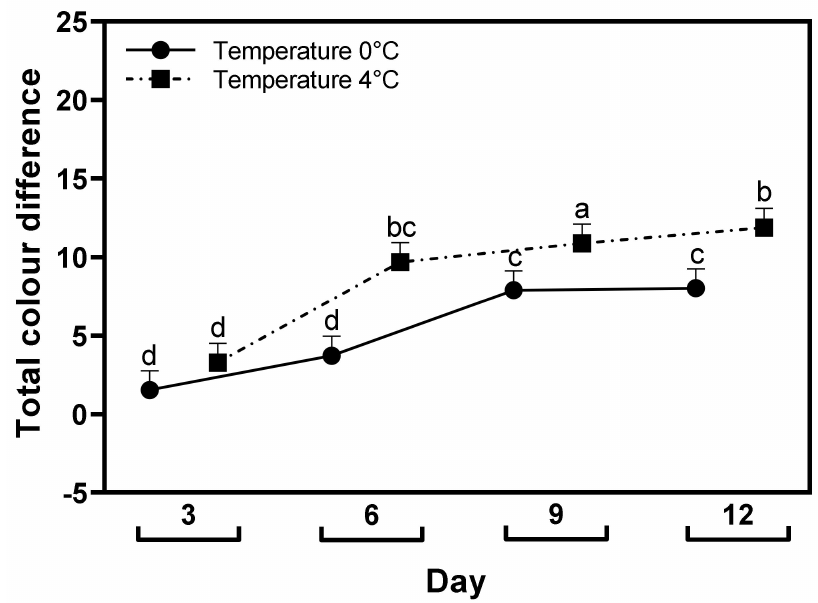
Figure 6. Effect of modified atmosphere packaging, temperature (0 ◦ C and 4 ◦ C), and duration (d) on total color difference of stored Cape hake fillets. Different letters indicate a significant difference in work of shear values ( p <